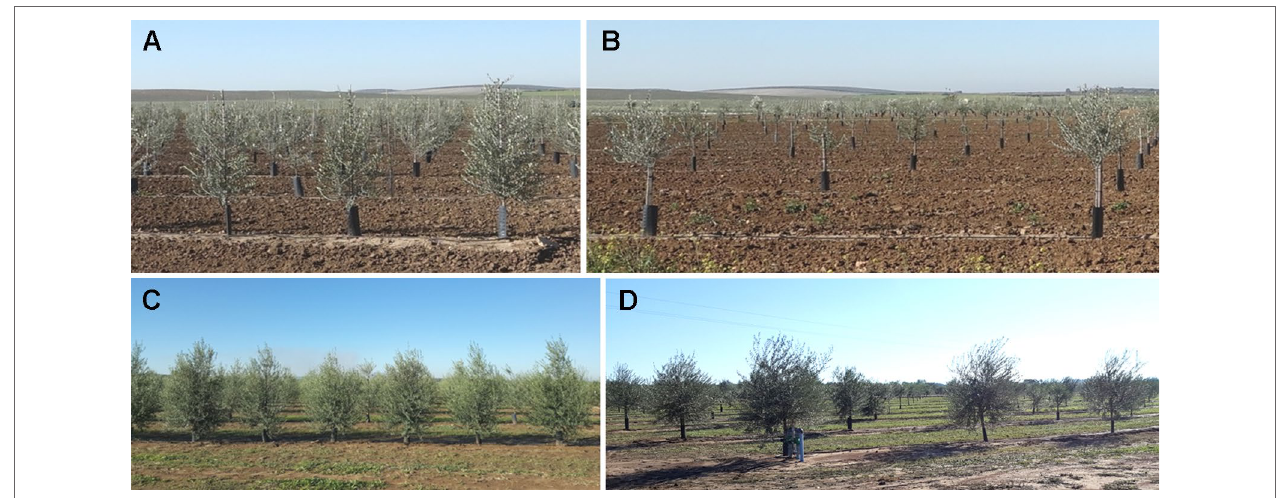
FIgUrE 1 | General view of the olive field trial studied: (A) hedgerow trial and (B) intensive trial in 2017; and (c) hedgerow trial; and (D) intensive trial in 2018.